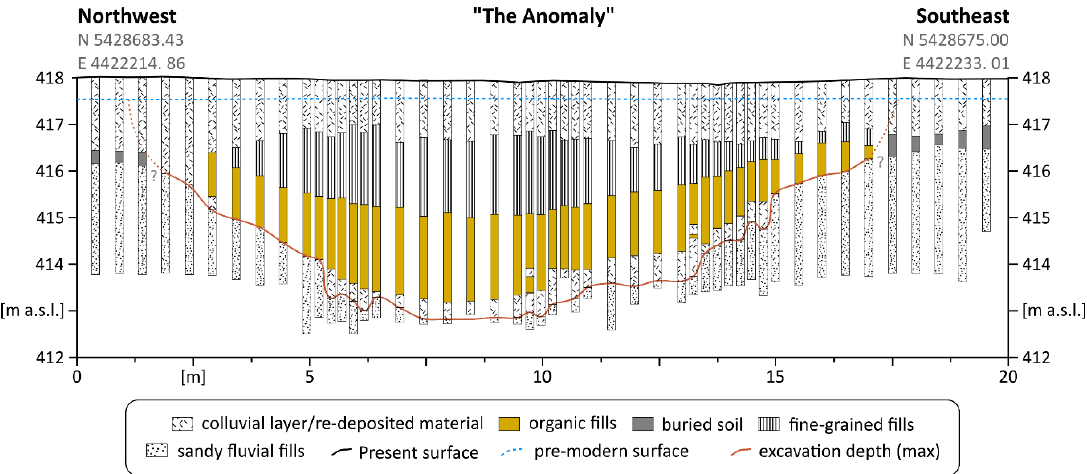
Figure 7. Cross-section reference geometry based on direct push sensing. The sketch of the “The Anomaly” transect shows present and pre-modern surface levels, trench geometries and maximum excavation depth.